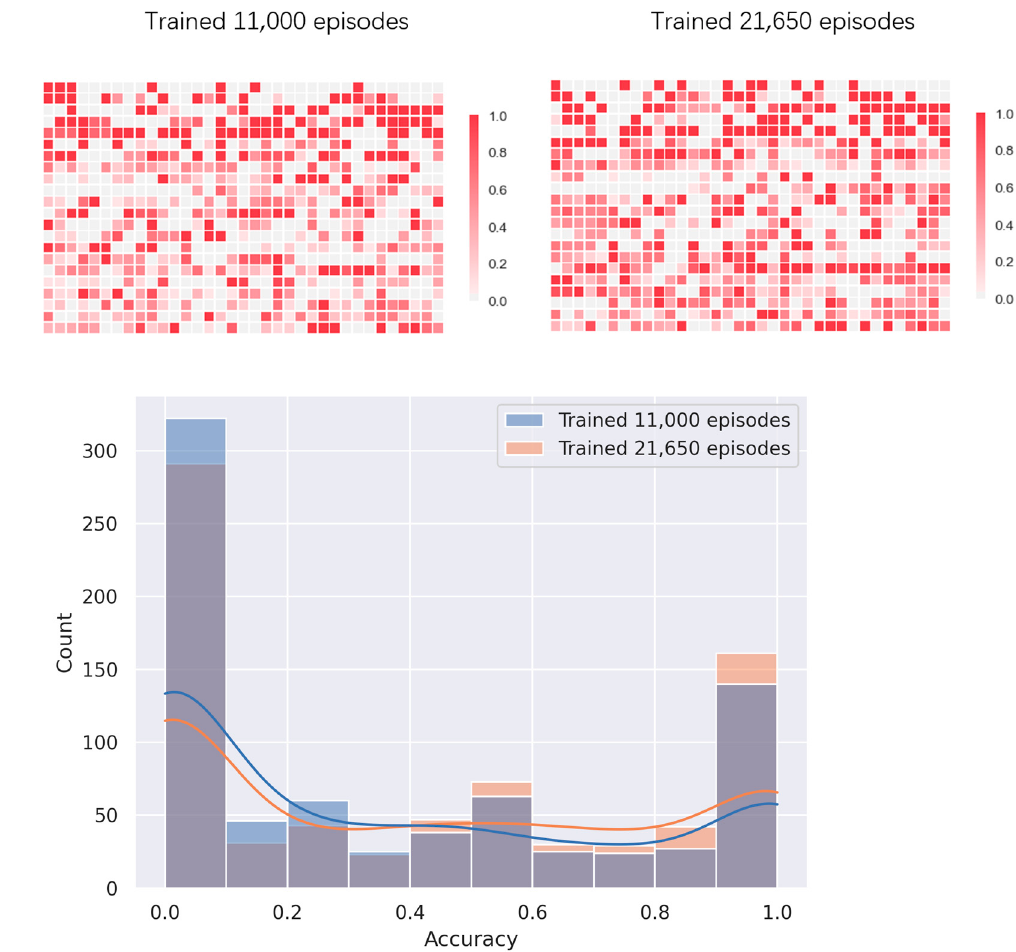
Figure 14. The prediction accuracy of each sample on the training set. On the upper left is the result at the 11,000th episode, and on the upper right is the result at the 21,650th episode. The bottom is the accuracy distribution chart.